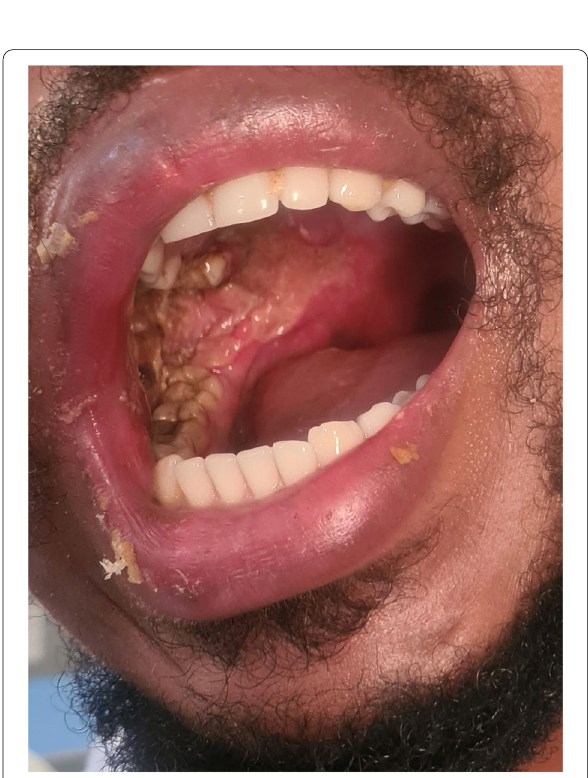
Fig. 2 Right inner buccal ulcerative and necrotising